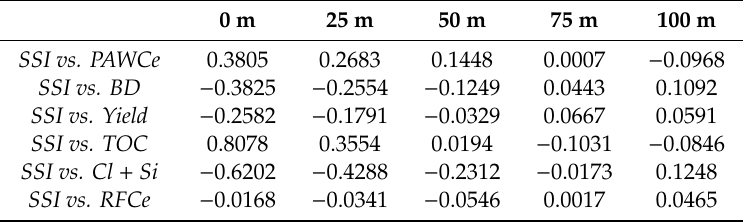
Table 5. Cross-correlation coe ffi cients computed at di ff erent lags between SSI and other indicators